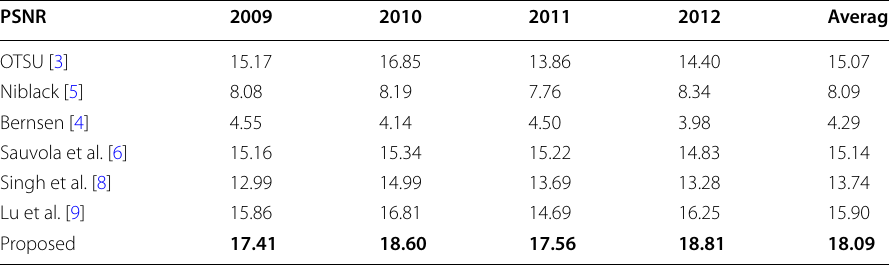
Table 2 Comparison of PSNR for seven